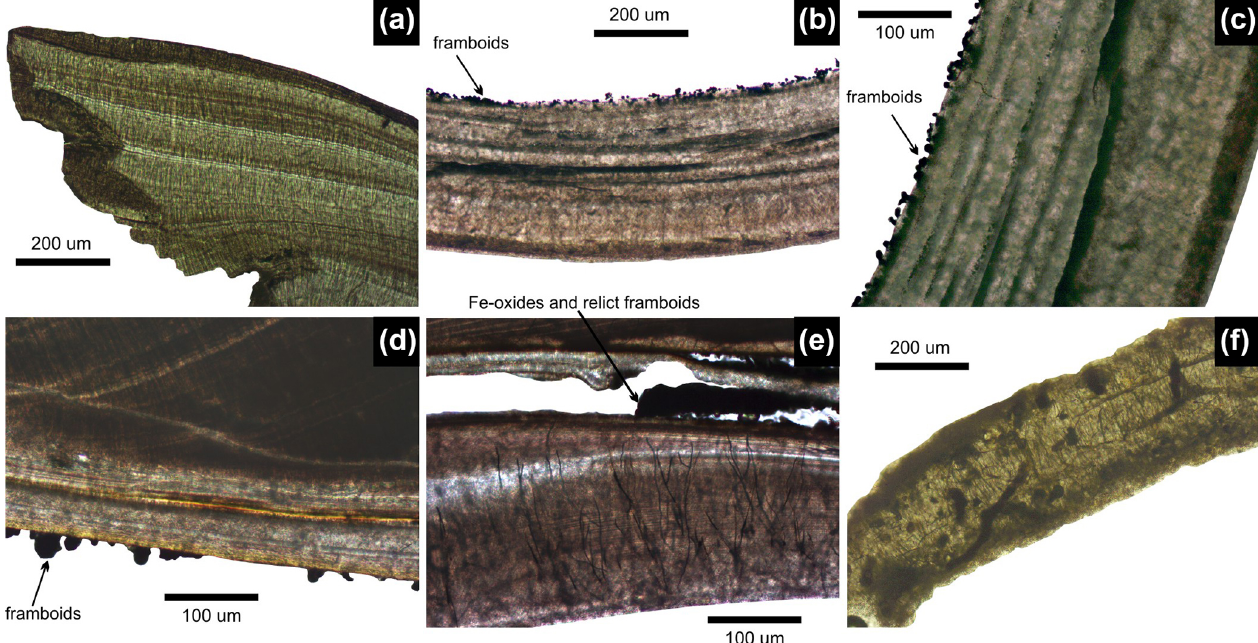
Figure 7. Thin-section photographs showing pyrite framboids on the inner surface of V. gibba and preservation of more altered valves. (a) A pristine right valve not lined by pyrite framboids, M13-65-79cm-29. (b–c) Internal surface of well-preserved right valve lined by pyrite framboids (arrows), M21-90-95cm. (d) Internal surface of well-preserved right valve lined by pyrite framboids, M14-40-45cm. (e) Internal conchiolin layer within the right valve, with a dark mixture of carbonate nodules and pyrite rimmed and replaced by Fe oxides, M20-120- 125cm. (f) Strongly bored valve filled with micrite and stained by nanopyritic inclusions,